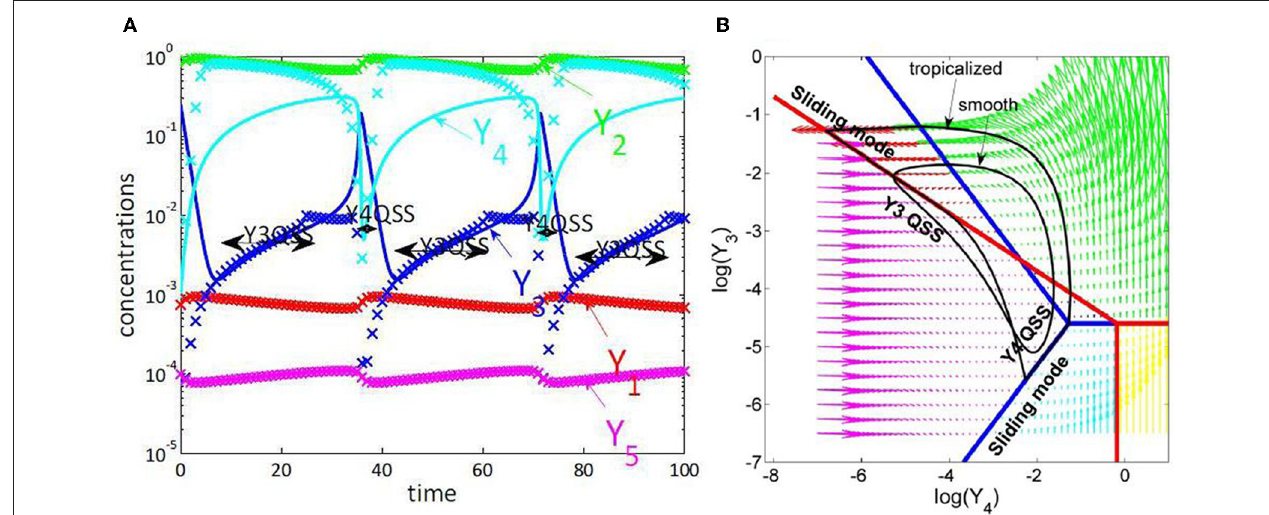
FIGURE 4 | Tropical geometry and cell cycle modeling. We considered the five variables cell cycle model defined by the differential equations y (cid:5) 1 = k 9 y 2 − k 8 y 1 + k 6 y 3 , y (cid:5) 2 = k 8 y 1 − k 9 y 2 − k 3 y 2 y 5 , y (cid:5) 3 = k (cid:5) 4 y 4 + k 4 y 4 y 2 3 / C 2 − k 6 y 3 , y (cid:5) 4 = − k (cid:5) 4 y 4 − k 4 y 4 y 2 3 / C 2 + k 3 y 2 y 5 , y (cid:5) 5 = k 1 − k 3 y 2 y 5 , proposed in Tyson (1991). (A) Comparison of trajectories and imposed trajectories show that variables y 1 , y 2 , y 5 are always slaved, meaning that the trajectories are close to the 2 dimensional hyperplane defined by the QE condition k 8 y 1 = k 9 y 2 , the QSS condition k 1 = k 3 y 2 y 5 and the conservation law y 1 + y 2 + y 3 + y 4 = C . The variables y 3 , y 4 are slaved and the corresponding species are quasi-stationary on intervals. This means that